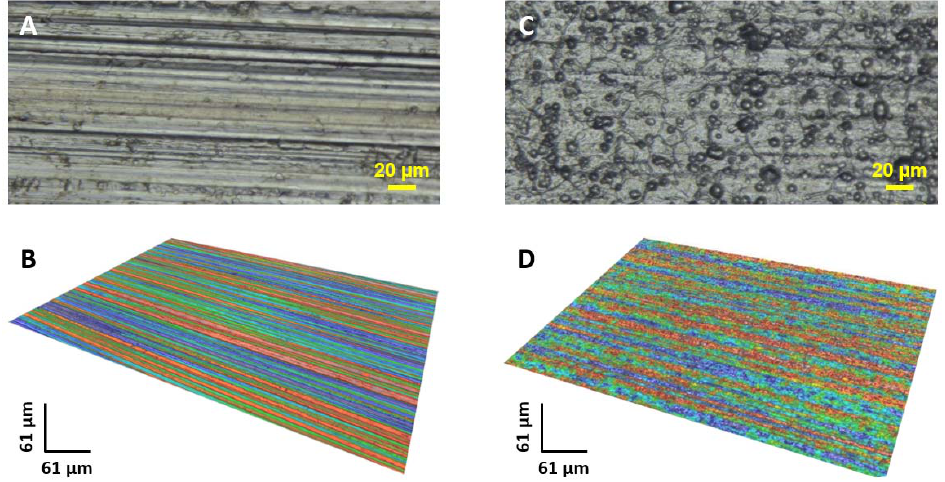
Figure 1. Optical micrographs of surface substrate ( A ) before and ( C ) after surface preparation and respectively ( B ) and ( D ) for the 3D reconstitution.